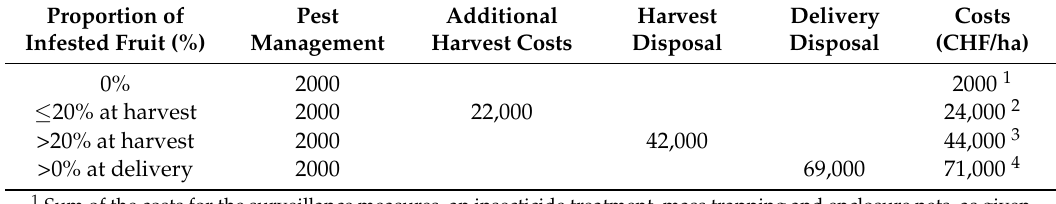
Table 7. Estimation of the costs sustained due to the occurrence of Drosophila suzukii in sweet cherry production areas of Switzerland under four scenarios of increasing fruit